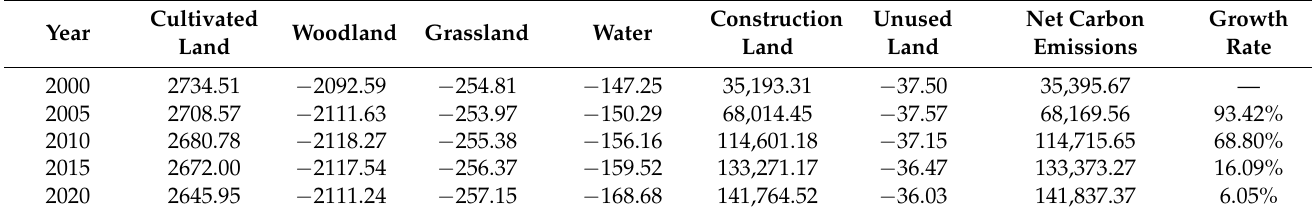
Table 2. Carbon emissions of different land types in the Yellow River Basin from 2000 to 2020 (10 4